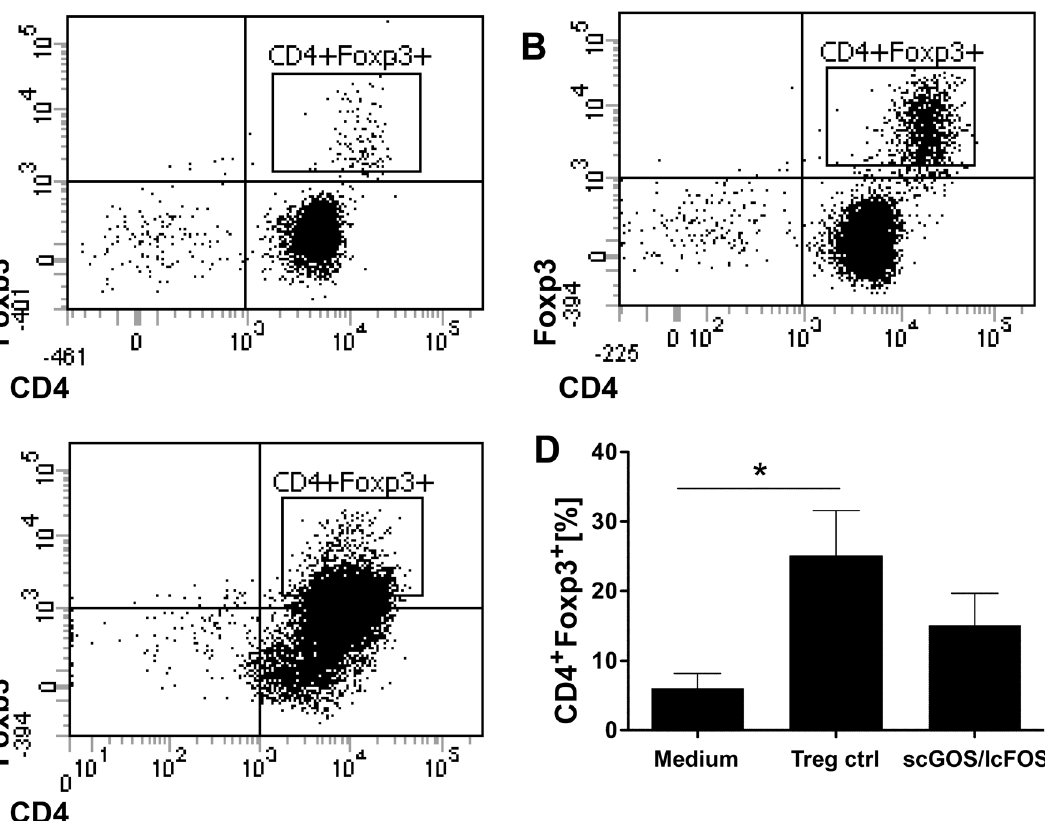
Fig 6. scGOS/lcFOS stimulated MoDC induce CD4 + Foxp3 + T cells. MoDC stimulated with scGOS/lcFOS (5 mg/ml) were used to prime na ï ve CD4 + CD45RA + T cells in an ASA. At day 7, cells were stained for CD4 and intracellular Foxp3 was analyzed by flow cytometry. The dot plots show data from one representative experiment (A-C). T cells that have been co-incubated with medium-treated MoDC served as medium/negative control (A) and a positive control for Treg polarization is shown in (B). CD4 + Foxp3 + T cells induced by scGOS/lcFOS stimulated MoDC are shown in (C). Data in (D) are expressed as percentages of CD4 + Foxp3 + cells. Results are presented as mean ± SEM, 4 independent experiments are shown (D). * p < 0.05, Mann Whitney test. ASA = allogeneic stimulation assay, scGOS/lcFOS = short chain galacto-, long chain fructo-oligosaccharides, MoDC = monocyte-derived dendritic cells.